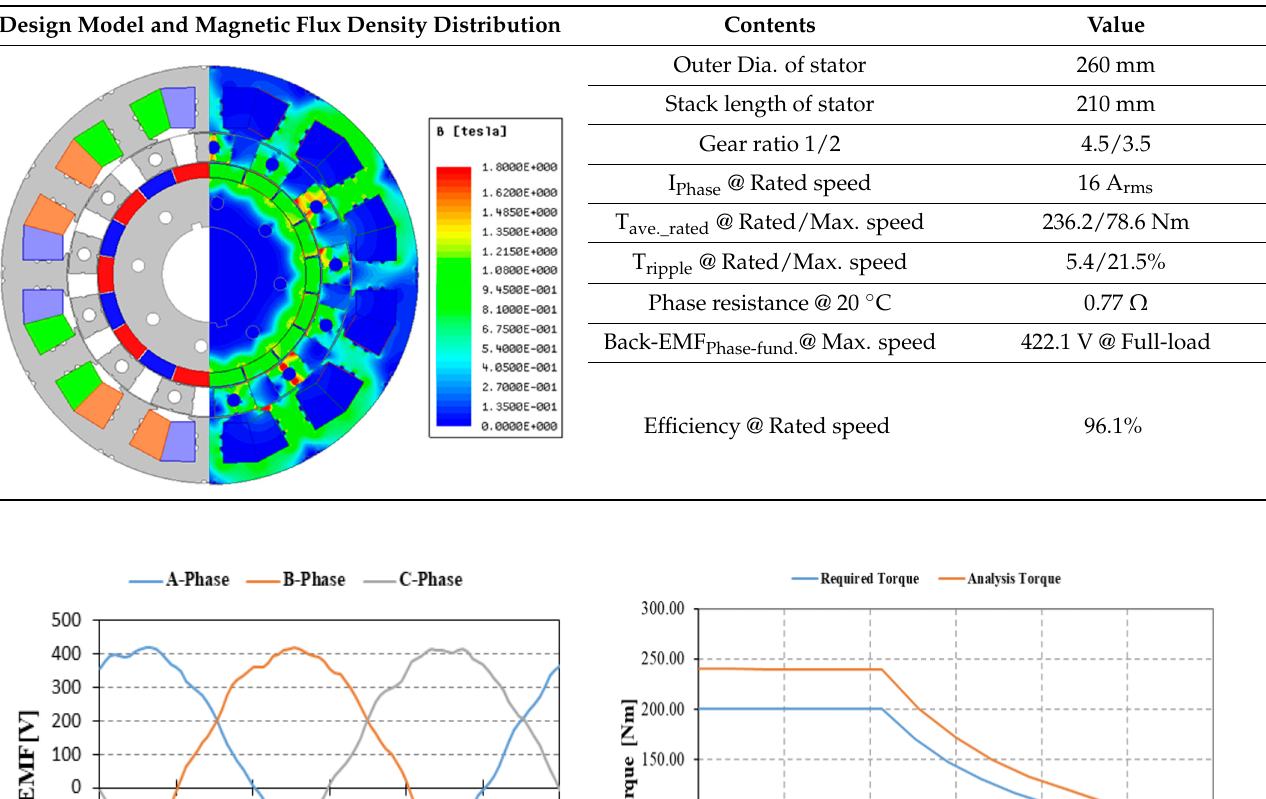
Table 7. Derivation results of the final design model of 4.5kW ‐ class small ‐ scaled MG ‐ PMSM prototype. Design Model and Magnetic Flux Density Distribution